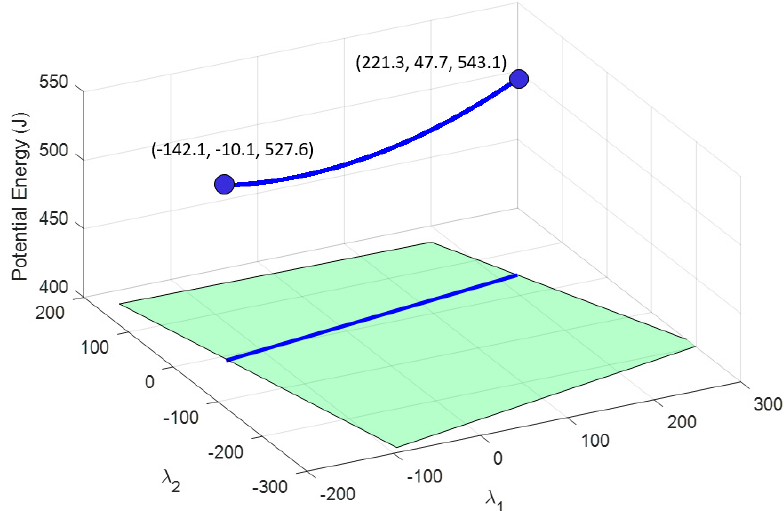
Figure 12. The blue 3D curve represents the potential energy stored in all cables that can be achieved by maintaining the condition of setting a deformation in cable 8 of 0.447 m and two grippers hanging from cables 1 and 8.